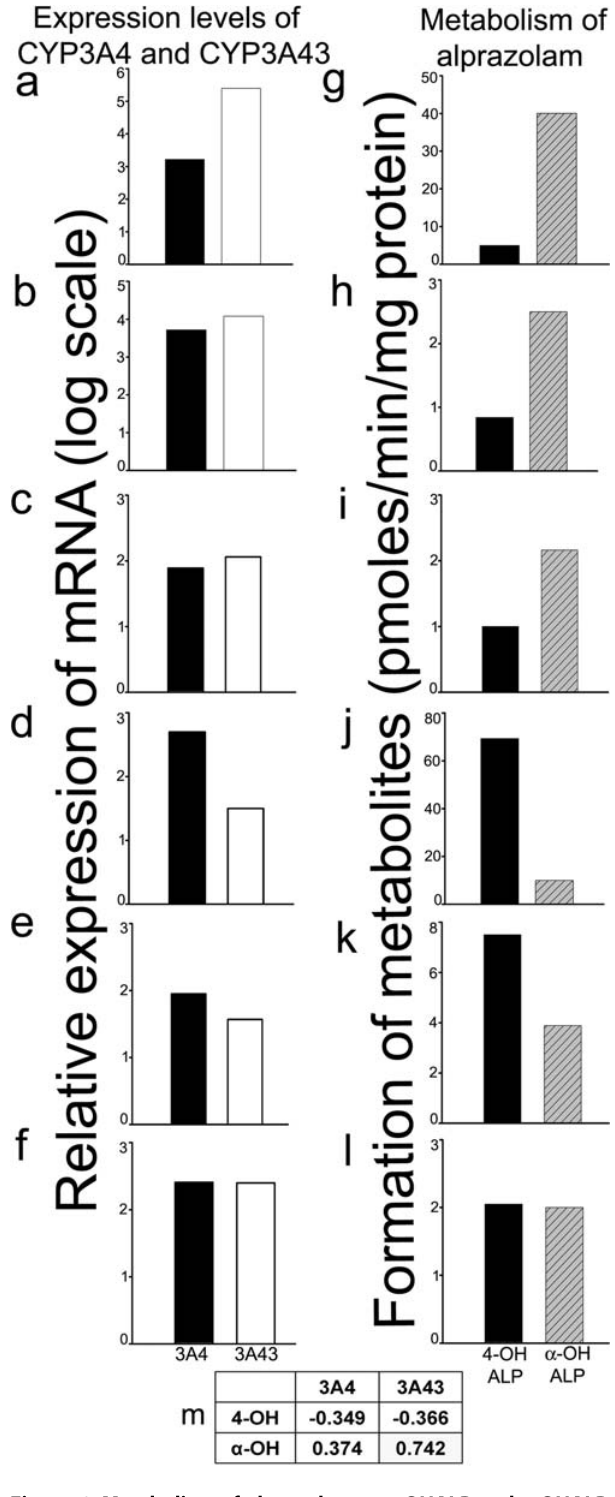
Figure 6. Metabolism of alprazolam to a -OHALP and 4-OHALP by human brain, in vitro. The expression levels of CYP3A4 and CYP3A43 were compared with the rates of formation of a -OHALP and 4- OHALP in samples of cortex obtained from 6 human brain subjects. Subjects represented in (a, b, c) expressed high levels of CYP3A43 and relatively higher amounts of a -OHALP was formed compared to 4- OHALP (g, h, i). Subjects (d, e) expressed high levels of CYP3A4 and formed relatively higher amounts of 4-OHALP (j, k). Subject (f)